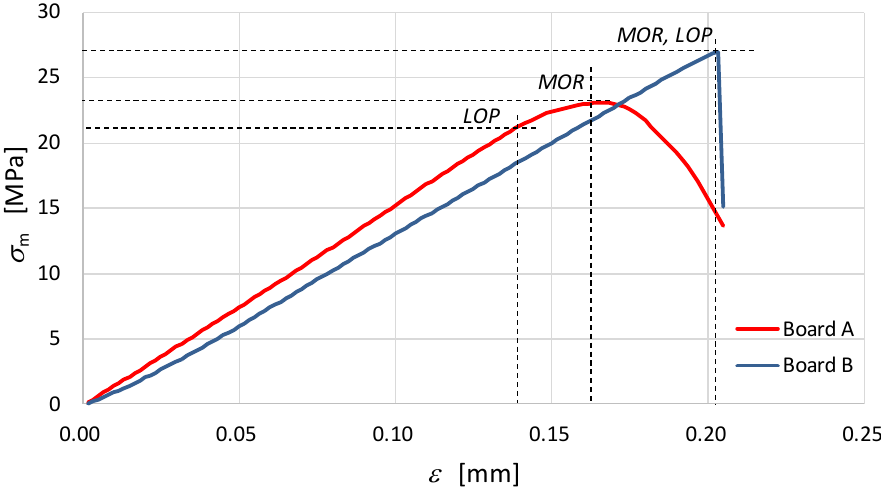
Figure 2. Diagrams of the σ - ε dependence under bending for fibre-cement boards.